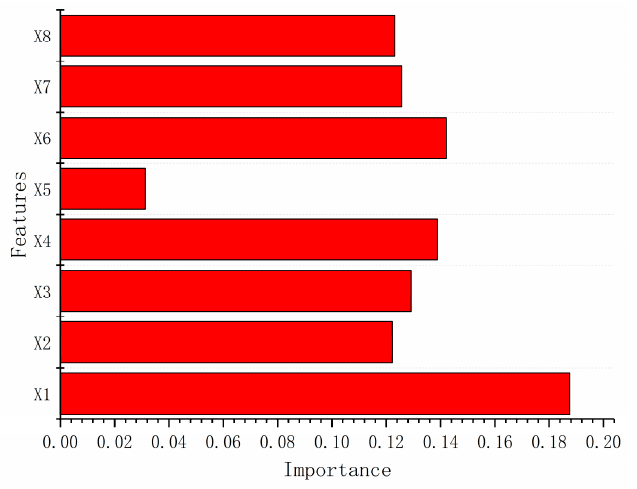
Figure 9. The importance of the features of the electricity consumption model.